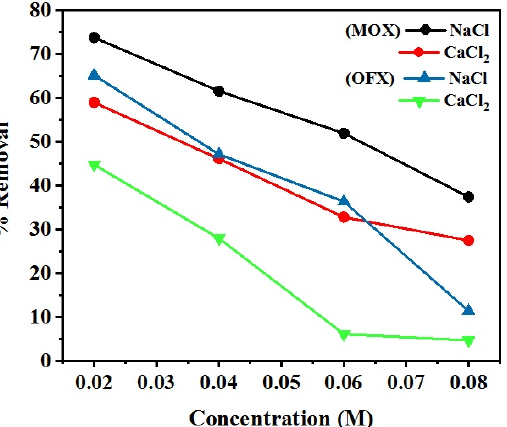
Figure 15. Effect of the ionic strength on adsorption of MOX and OFX on Met-GO/SA.